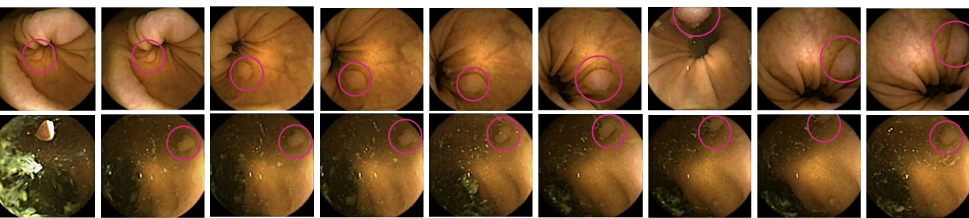
Figure 2. Two sequences in which the physicians have identified polyps. The upper sequence shows the polyp appearing in different locations of the images, whereas in the second sequence, the polyp (upper right corner) stays in approximately the same place while the capsule is